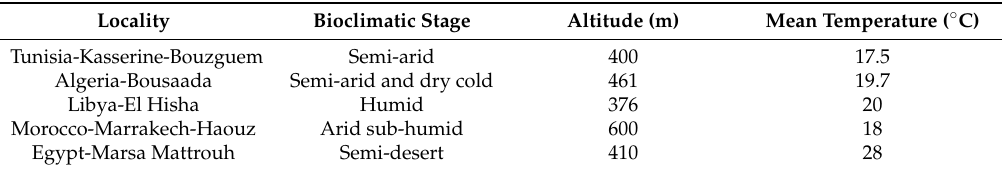
Table 5. Harvest site